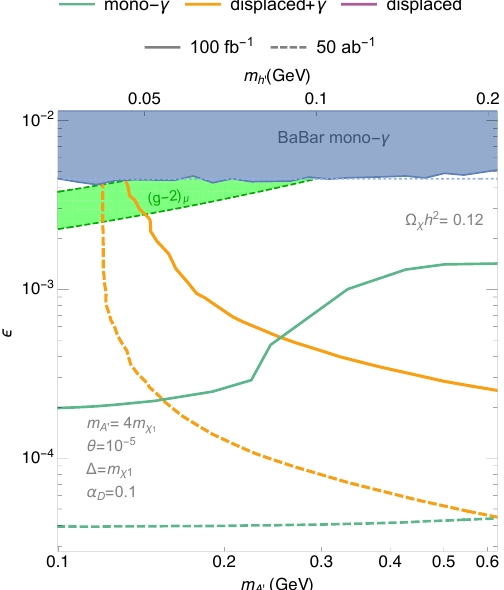
Figure 7 . Expected sensitivities of the different searches at Belle II in the (cid:15) − m A 0 parameter plane for integrated luminosities of 100 fb − 1 (solid lines) and 50 ab − 1 (dashed lines), similar to figure 3, but zoomed into the region in which the anomalous magnetic moment of the muon can be explained (green). The dark Higgs mass m is chosen such that the correct relic abundance is achieved for h 0 all values of m (see upper axis for required value of m ). The preferred range for the anomalous A 0 h 0 magnetic moment in this figure is calculated including the recent observation from